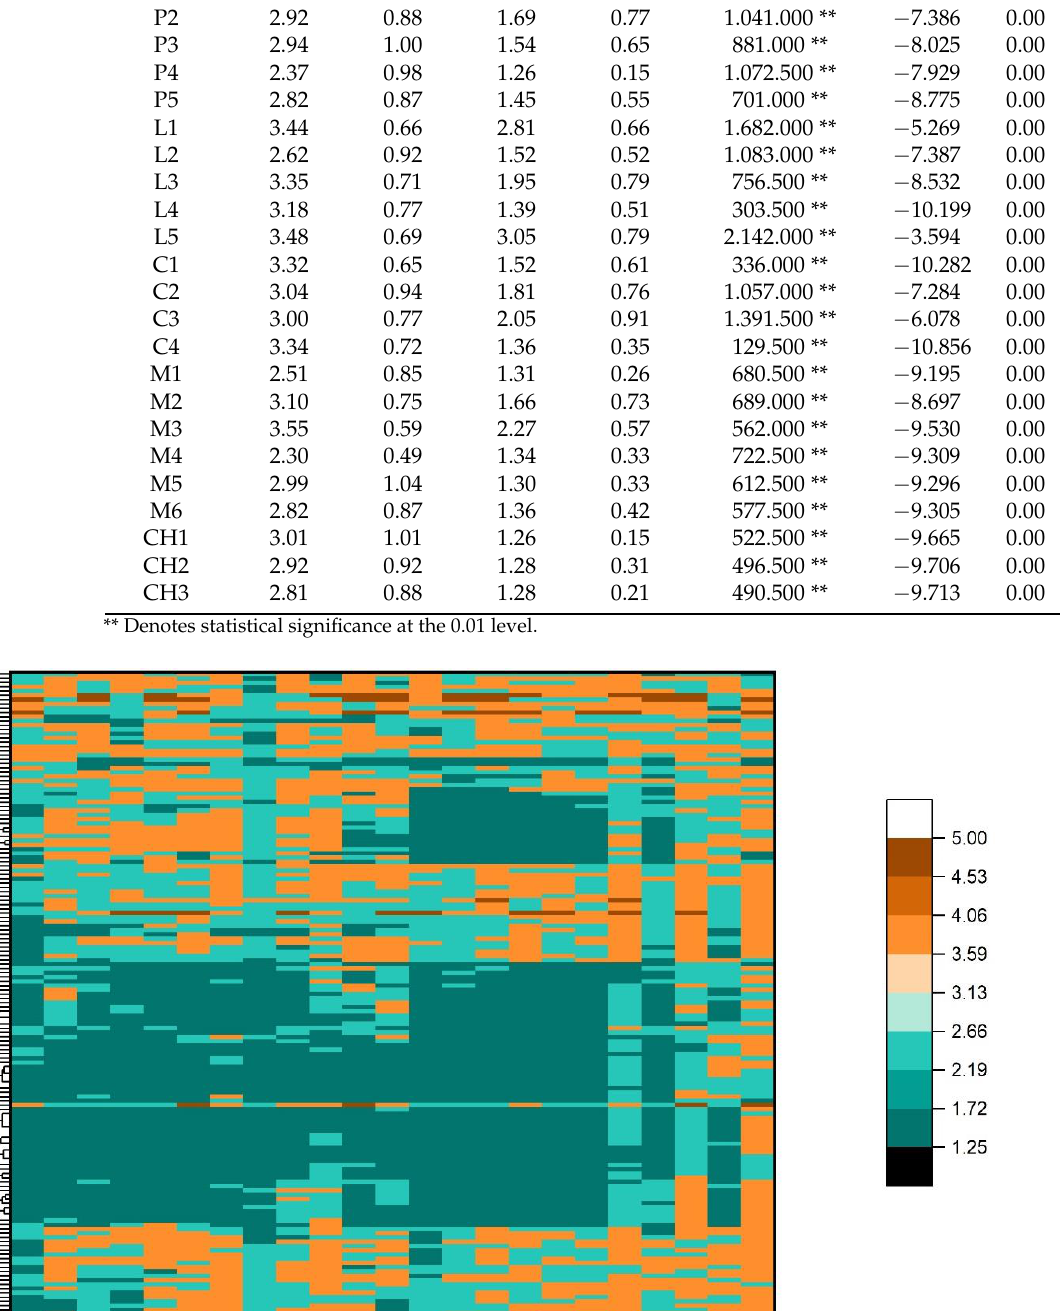
Table 5 indicates the differences between clusters depending on the farmers’ socio- economic profiles and their farm characteristics. The chi-squared test results revealed a significant difference at the 0.05 probability level between the two clusters according to age, education level, farm size, farming experience, the number of date palm trees on the farm, off-farm income, farming activities, source of irrigation, type of irrigation, the grow- ing of the ‘Khodri’ cultivar, growing of the ‘Barhi’ cultivar, and tree spacing. However, no significant difference ( p > 0.05) existed between the two clusters for the performance of extension activities related to RPW in the last three years, the growing of the ‘Shishi’ cul- tivar, growing of the ‘Khalas’ cultivar, and growing of the ‘Salg’ cultivar. These results indicate that the variables studied are useful for distinguishing between the two clusters.